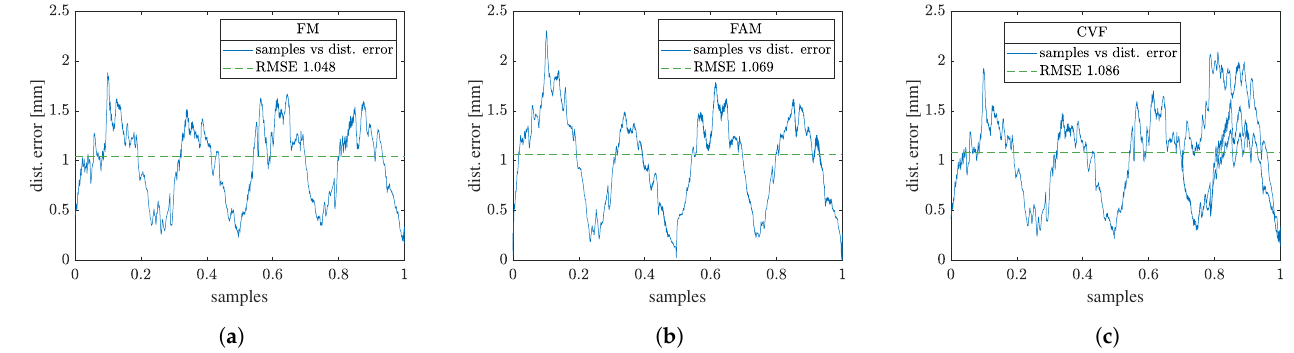
Figure 9. RMSE and distance error plot for each test. ( a ) FM. ( b ) FAM. ( c )